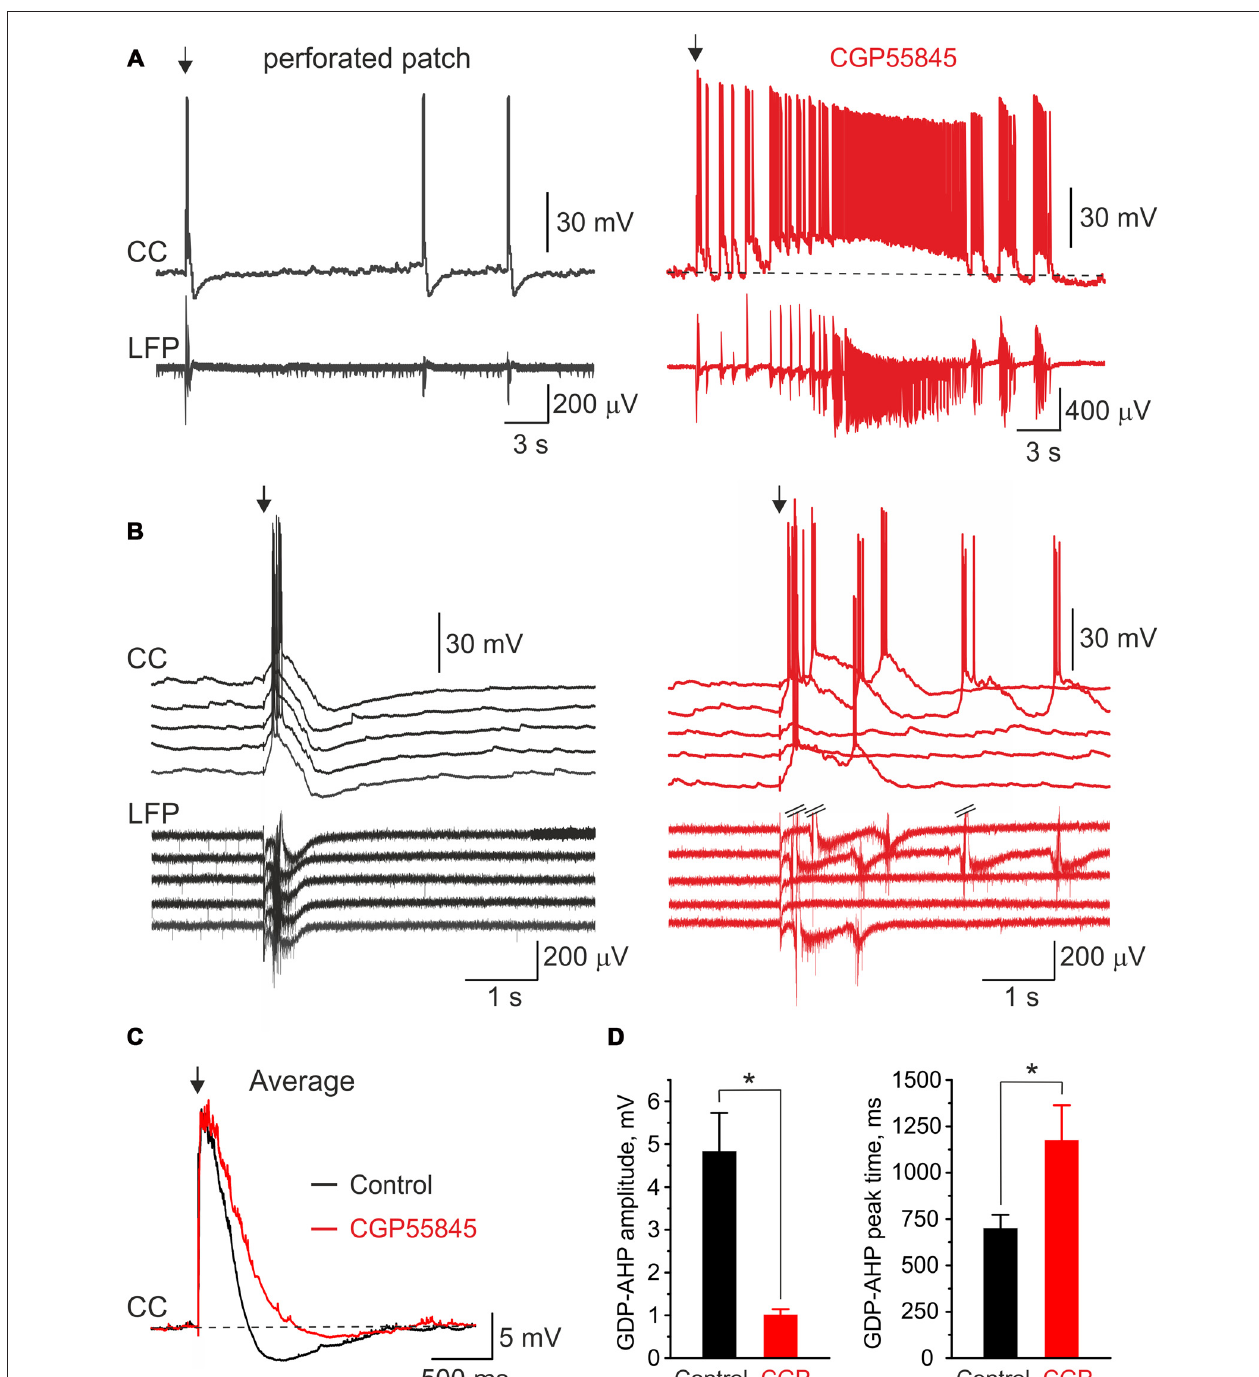
FIGURE 7 | Blockade of GABA(B) receptors suppresses GDP-AHP. (A) Gramicidin perforated patch current-clamp recordings from a CA3 pyramidal cell (CC, top trace) and LFP recordings from CA3 pyramidal cell layer from the hippocampal slices of a P7 rat under control conditions (left, black traces) and after bath application of the GABA(B) receptor antagonist CGP55845 (100 nM; right, red traces). The first GDP on each trace is triggered by the electrical stimulus (arrow) in s. radiatum . Note an ictal-like discharge triggered by the electrical stimulus in the presence of CGP55845. (B) Example traces of five electrical stimulus-triggered eGDPs on expanded time scale before (left) and after (right) addition of CGP55845. (C) Average eGDPs from five P4–P7 CA3 pyramidal cells before (black, 144 eGDPs) and after (red, 115 eGDPs) addition of CGP55845. Note an increase in duration of eGDPs and partial suppression of the GDP-AHP by CGP55845. (D) Effect of CGP55845 on the GDP-AHP amplitude (left graph) and the delay of the GDP-AHP peak from the stimulus (right graph). Pooled data from six cells (P4–P7 rats), ∗ P < 0.05.